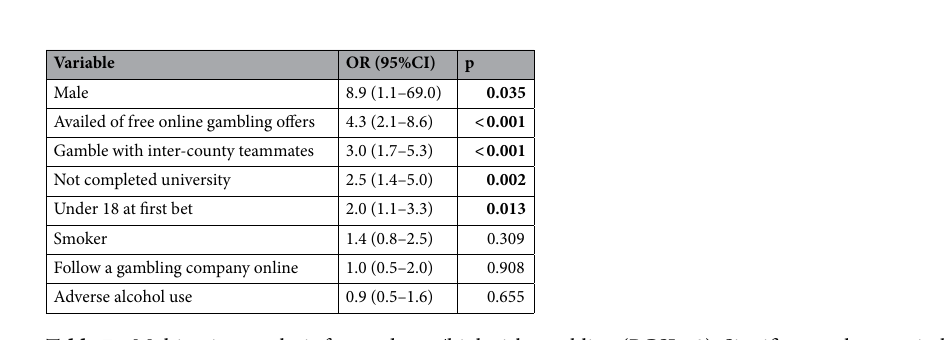
Table 7. Multivariate analysis for moderate/high risk gambling (PGSI ≥ 3). Significant values are in bold.